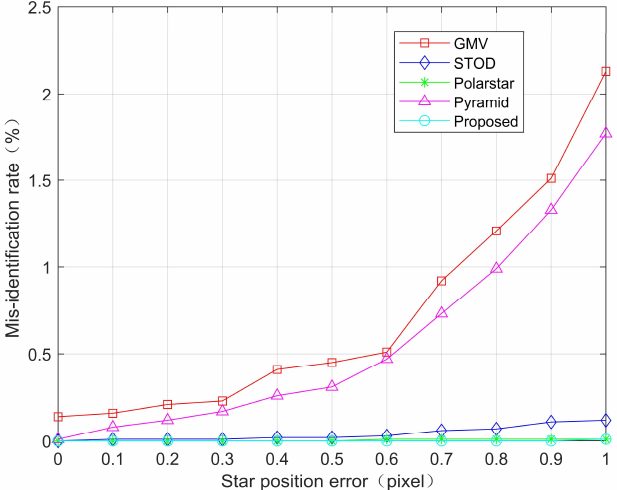
Figure 18. Misidentification rate benchmarking for sensitivity to star positioning errors.